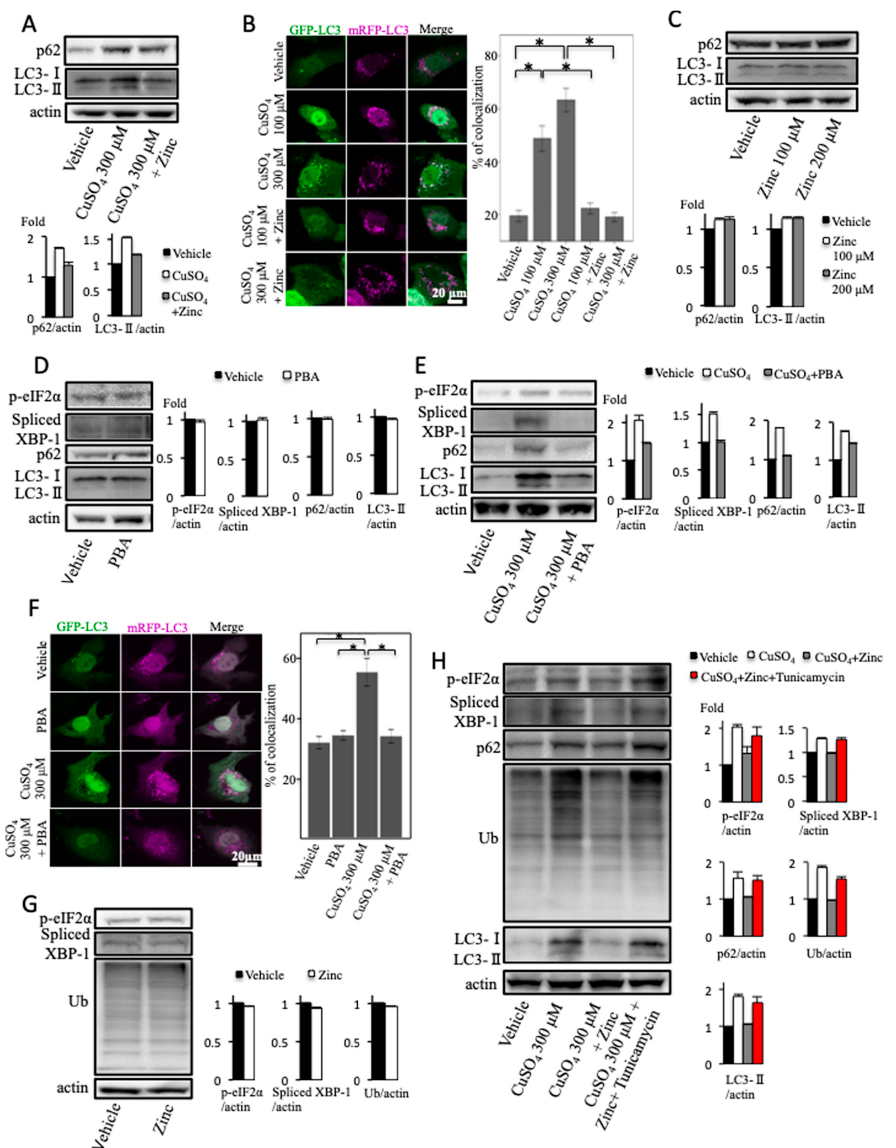
Figure 3. Effect of copper and zinc acetate treatment on autophagy. ( A ) Huh7 cells were treated with copper at the concentration of 300 μ M for 12 h, and zinc acetate (200 μ M) was added 2 h before copper sulfate treatment. Densitometry analysis of indicated proteins is shown on the bottom. ( B ) OUMS-29 cells were transfected with monomeric red fluorescent protein (mRFP)–green fluorescent protein (GFP) tandem fluorescent-tagged light chain 3 (LC3) plasmids. They were treated with copper at concentrations of 100 or 300 μ M for 12 h, and zinc acetate (200 μ M) was added 2 h before copper sulfate treatment. Colocalizations of mRFP and GFP signals were measured by counting an overall total of 30 to 40 cells over the course of three independent experiments. Colocalization was shown as the percentage of merged signals in the total number of mRFP signals. Data are expressed as means ± SEM. ( C ) Huh7 cells were treated with zinc acetate at concentrations of 100 or 200 μ M for 2 h. Densitometry analysis of indicated proteins is shown on the bottom. ( D ) Huh7 cells were treated with 4-phenylbutyrate (PBA) at the concentration of 5 mM for 2 h. Densitometry analysis of indicated proteins is shown on the right. ( E ) Huh7 cells were treated with copper at the concentration of 300 µ M for 12 h, and PBA (5 mM) was added 2 h before copper sulfate treatment. Densitometry analysis of indicated proteins is shown on the right. ( F ) OUMS-29 cells were transfected with mRFP–GFP tandem fluorescent-tagged LC3 plasmids. They were treated with copper at the concentration of 300 µ M for 12 h, and PBA (5 mM) was added 2